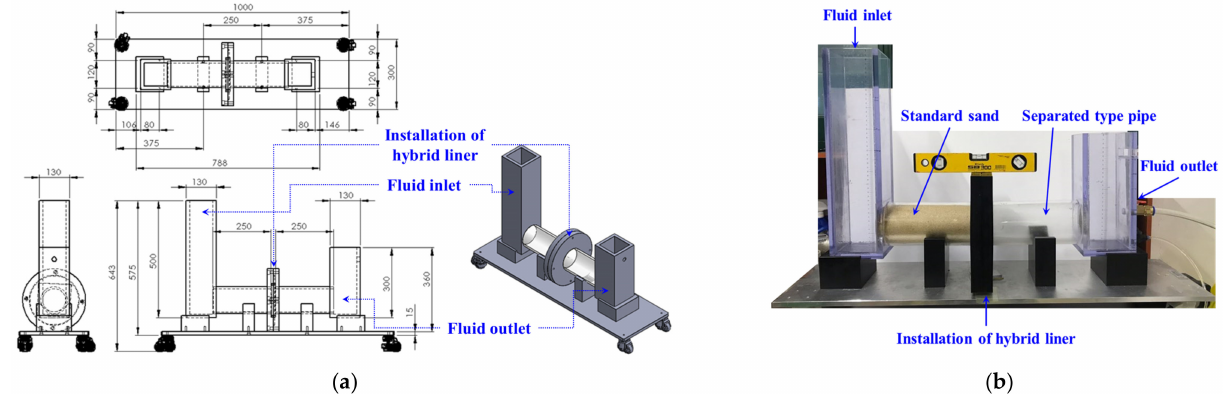
Figure 3. Permeability test apparatus: ( a ) Schematic; ( b ) Set-up.